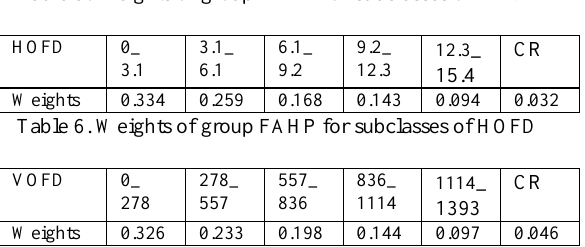
Table 5. Weights of group FAHP for subclasses of NDVI